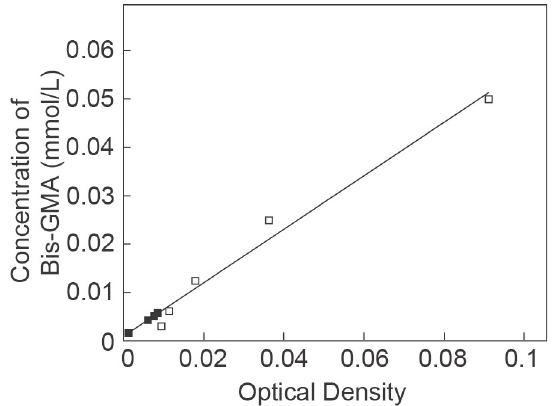
Figue 4- Calibration curve of known concentrations of 2, 2-bis [4-(2-hydroxy-3-methacryloxypropoxy) phenyl] propane (Bis-GMA) and concentrations of Bis-GMA that penetrated 1 mm dentin discs. White rectangles indicate known concentrations of control Bis-GMA for the calibration curve. Black rectangles indicate concentrations calculated from HPLC results of penetrated